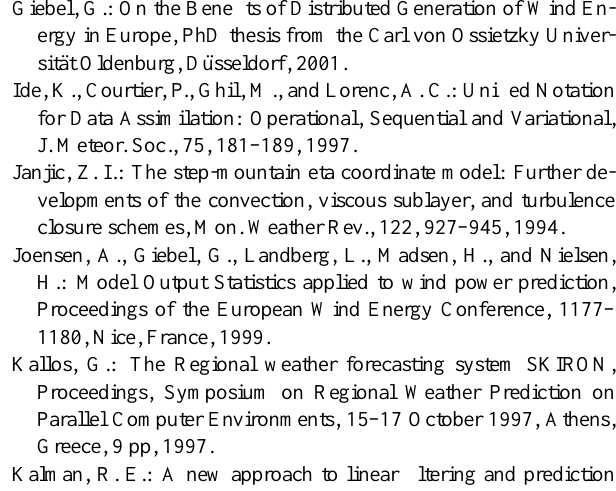
Fig. 9. Variation of (a) temperature and (b) wind speed Standard Deviation of Bias with forecast time for the direct model output and after the application of order-3 Kalman filter, for the year 2003